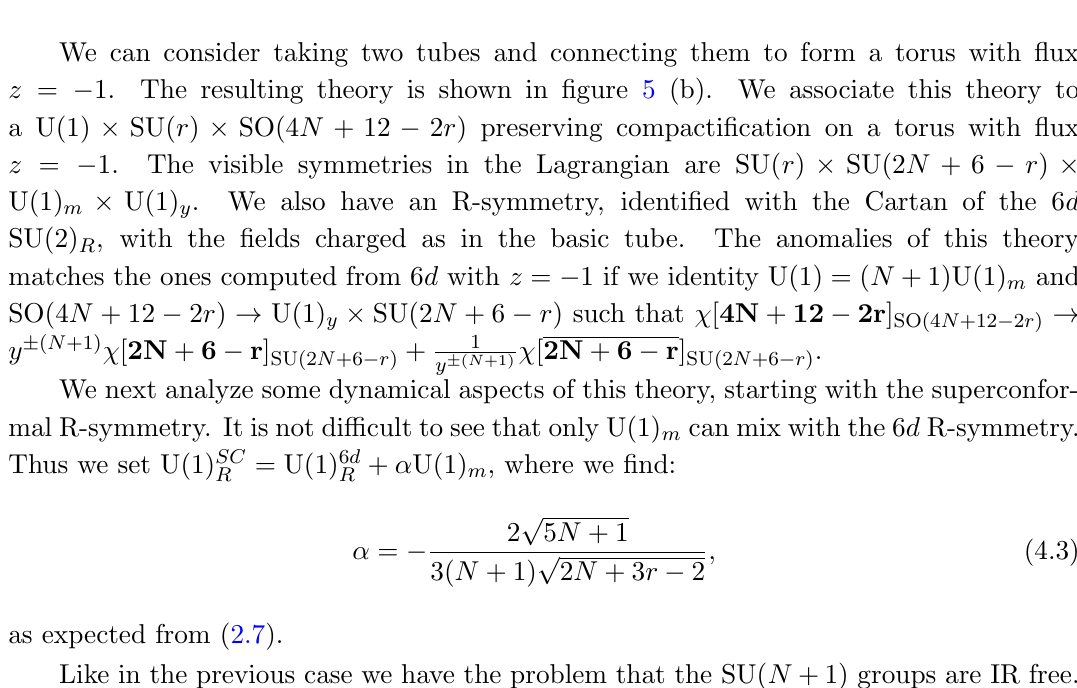
Figure 5. 4 d theories corresponding to compacti(cid:12)cations with (cid:13)ux preserving SU( r ) SO(4 N + 12 2 r ). All groups are SU except the ones with 2 N that are symplectic, USp . Here (cid:0) r is even so that the USp(2 N ) gauge group is not anomalous. For bifundamentals between SU groups we adopted a double arrow notation indicating whether the (cid:12)eld is in the fundamental or antifundamenal of each SU group. Like before the arrow from the SU group to itself stands for an antisymmetric chiral (cid:12)eld. (a) The theory corresponding to a tube with (cid:13)ux z = There are cubic superpotentials for every triangle and for every antisymmetric chiral coupling it to two bifundamentals. Additionally there is a quartic superpotential for the lower ‘triangle’. (b) Connecting two tubes leads to this